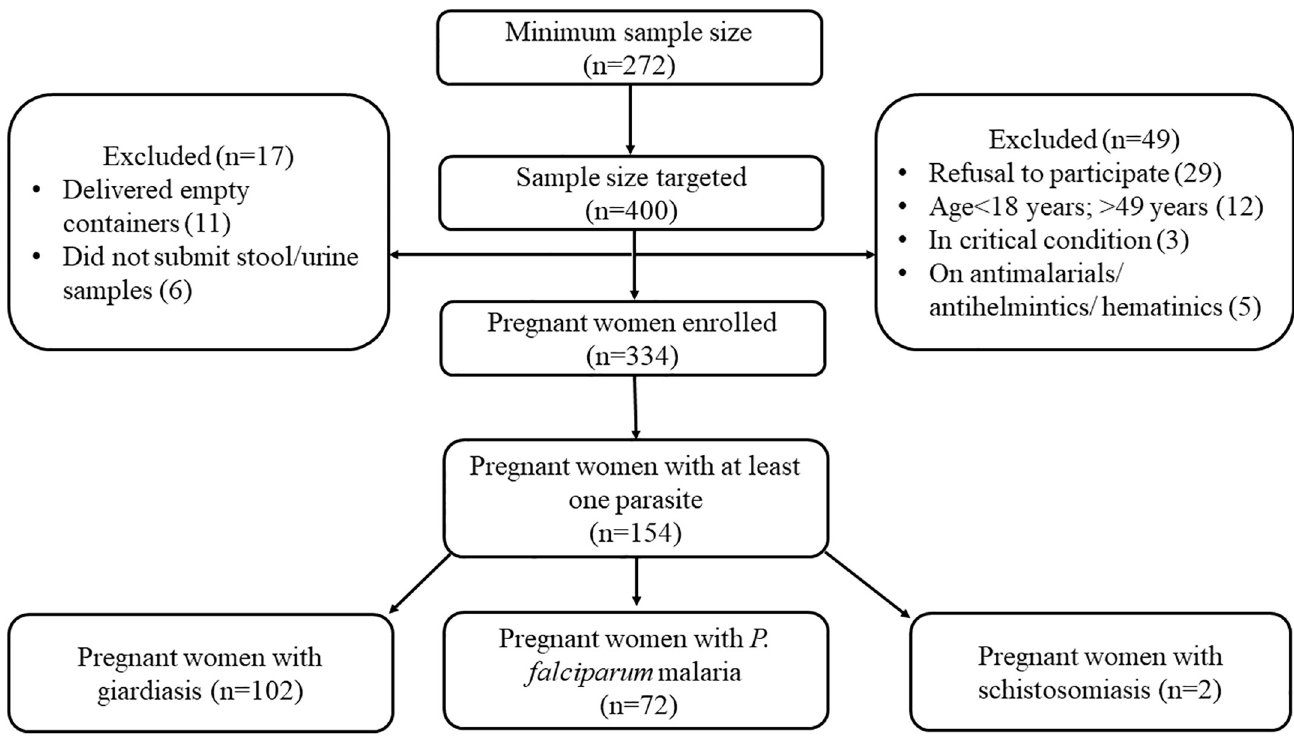
Fig 1. Flowchart of participation in the